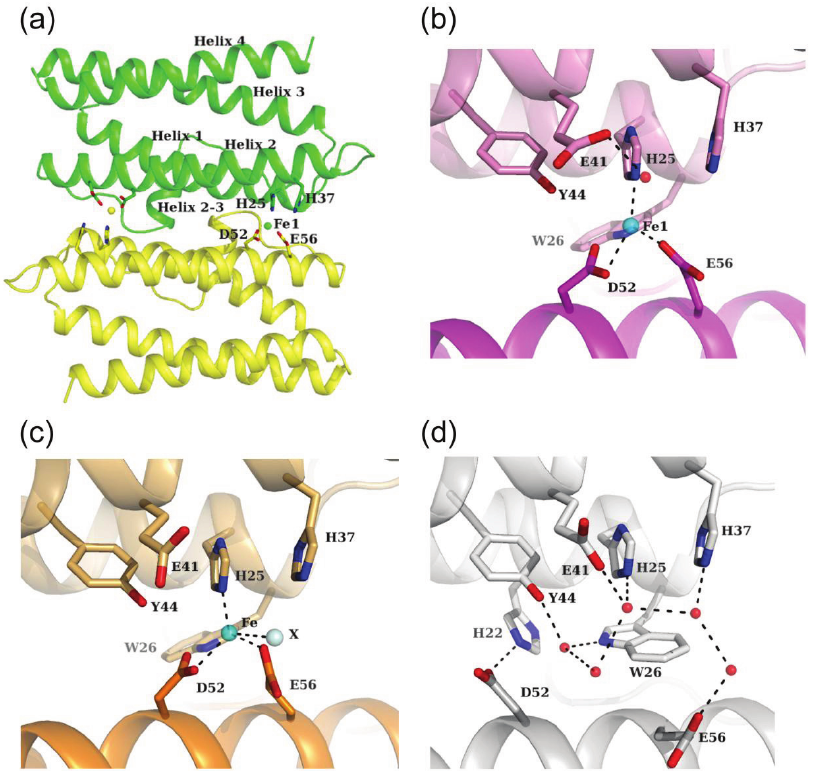
Figure 4. Ferroxidase center. ( a ) Two ferroxidase centers are located in the interface of the dimer in Fe-loaded HP-NAP YS39. His25 and His37 of one subunit (green) and Asp52 and Glu56 of the other subunit (yellow) are chelated to iron ions. Fe1 indicates the first iron ion. This figure is viewed from the inner side of the dodecamer; ( b ) A close-up view of the FOC in Fe-loaded HP-NAP YS39. Iron and water molecules are shown as cyan and red spheres, respectively. Dashed lines indicate coordinate bonds or hydrogen bonds; ( c ) A close-up view of the FOC in Fe-loaded HP-NAP 26695. An unidentified solvent molecule is shown as palecyan; ( d ) A close-up view of the FOC in the HP-NAP YS39 apo (PDB ID: